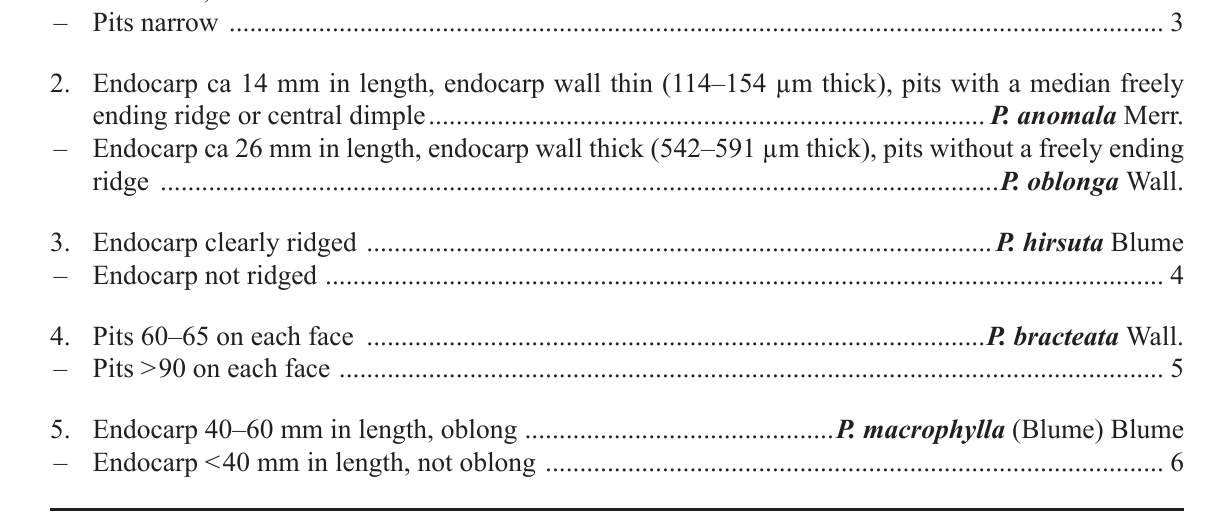
Fig. 20. Fruits of Icacinaceae Miers. 1 – 9 . Nothapodytes nimmoniana (J. Graham) Mabb. ( A.H.H. Jayasuriya 1922 ). 1 . Dried fruit, lateral view. 2 – 6 . Broken endocarp. 2 . Lateral view showing the roughness. 3 . Dorsal view of the endocarp with a channel. 4 . Opposite lateral view. 5 . Apical view. 6 . Basal view. 7 . SEM image of the pericarp in transverse section. 8 . Detail showing the inner part of the endocarp cells. 9 . Other detail showing the outer part of the endocarp cells. – 10 – 18 . Nothapodytes pittosporoides (Oliv.) ( s. col. 4118 ). 10 . Dried fruit, lateral view. 11 – 15 . Endocarp. 11 . Lateral view showing the roughness. 12 . Dorsal view of the endocarp with a channel. 13 . Opposite lateral view. 14 . Apical view. 15 . Basal view. 16 . SEM image of a pericarp transverse section showing the vascular bundle in a channel. 17 . SEM image of a pericarp transverse section with a vasculature between mesocarp and endocarp. 18 . SEM image of the endocarp cells in transverse section. – 19 – 26 . Phytocrene anomala Merr. ( M. Ramos 1840 ). 19 . Dried fruit with an accrescent apex, lateral view. 20 – 25 . Endocarp. 20 . Lateral view showing the pits in broad, concave pits. 21 . Dorsal view. 22 . Opposite lateral view. 23 . Apical view. 24 . Basal view. 25 . SEM image of the endocarp showing a pit in transverse section. 26 . SEM image of the endocarp wall in transverse section. Images taken from Del Rio (2018). Scale bars: 1–6, 10–15, 19–24 = 10 mm; 7, 16–17, 25 = 500 μm; 18 = 300 μm; 8–9 = 200 μm; 26 = 100